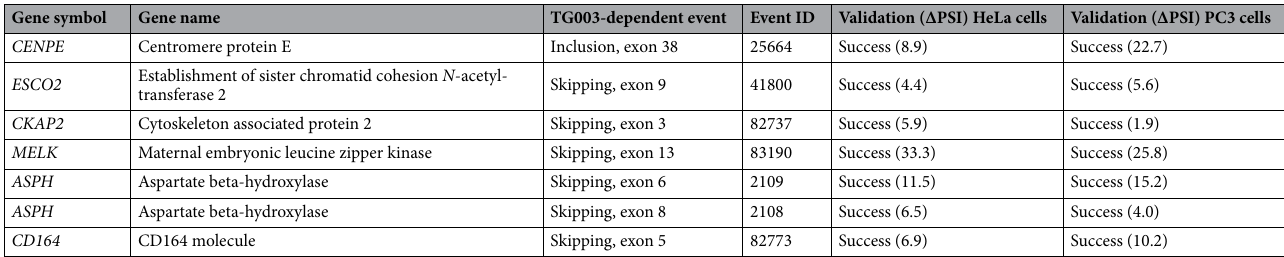
Table 1. List of validated TG003-responsive alternative splice events 32 . The seven top hits are shown, listing the gene symbols and names, the nature of the altered splicing event, the event ID, and the validation of the ΔPSI in both HeLa and PC3